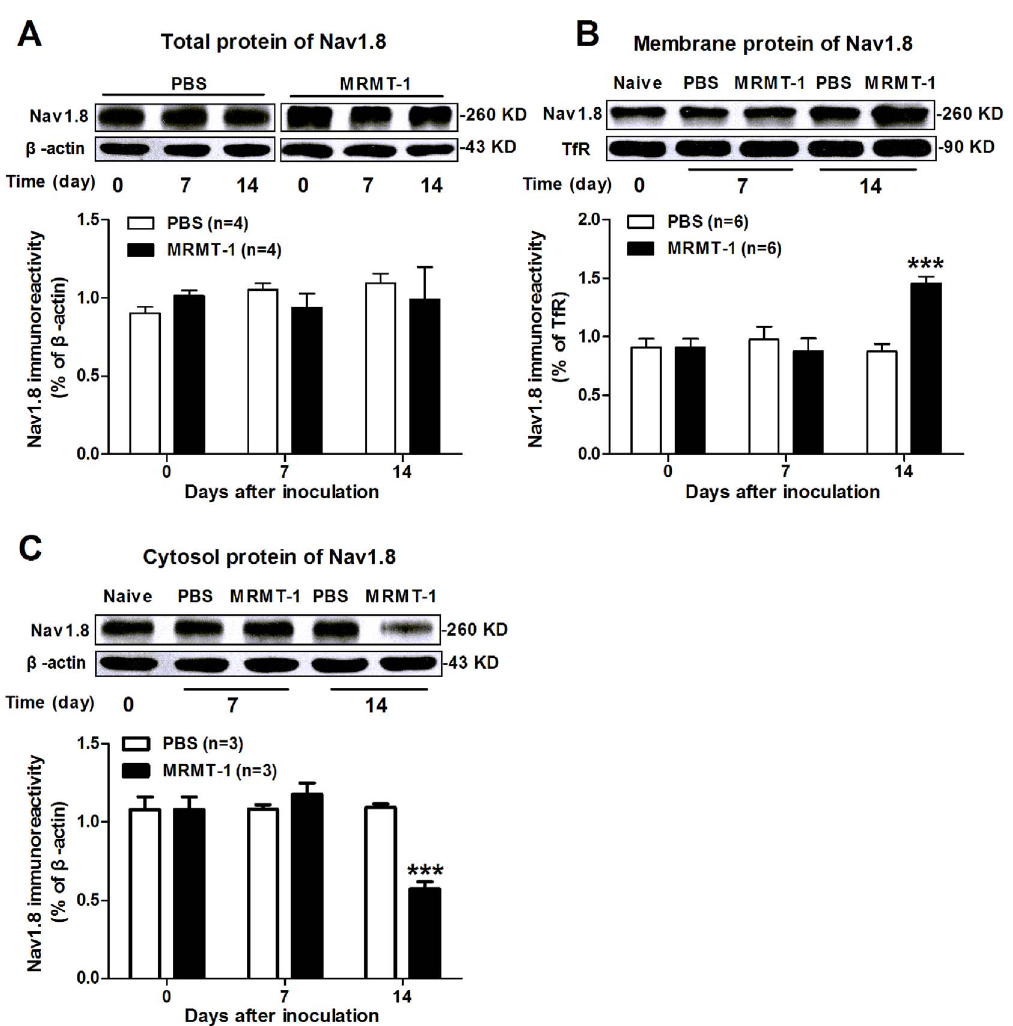
Fig. 3. Expression of Nav1.8 protein in the DRG in naı¨ve, PBS-treated and MRMT-1-treated rats. (A): Total Nav1.8 protein. Upper: representative of Western blot bands; Lower: statistical analysis of Nav1.8 total protein expression. No significant difference is observed on the expression of Nav1.8 total protein among the three groups. P . 0.05, two-way ANOVA, n 5 4/group. (B): Nav1.8 membrane protein. Upper: representative of Western blot bands. Transferrin receptor (TfR) is used as internal control. Lower: statistical analysis of Nav1.8 membrane protein expression. Note that the expression of Nav1.8 on the cell membrane is increased significantly in the DRG neurons of MRMT-1-treated rats compared to PBS-treated rats. *** P , 0.001, two-way ANOVA, n 5 6/group. (C): Nav1.8 protein in the cytosol. Note that the expression of Nav1.8 in the cytosol is significantly decreased in the DRG neurons of MRMT-1- treated rats compared to PBS-treated rats. *** P , 0.001, two-way ANOVA, n 5